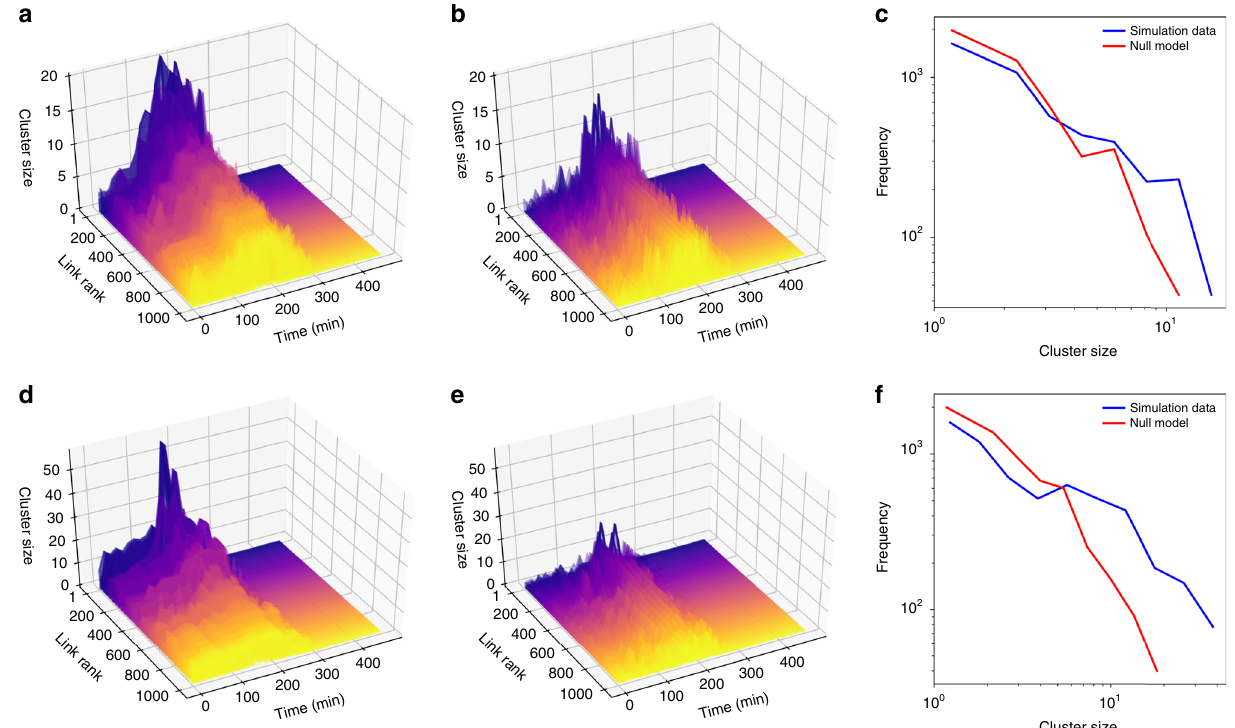
Fig. 6 Evolution of the congested upstream clusters associated with congested links. Here, a and d show the change over time in the size of the congested clusters associated with links in Melbourne ’ s traf fi c network, while b and e depict the same results for the null model generated independently for each time step by drawing random λ i ( t ) ’ s for each link i from the same distribution as in the simulated data; links are sorted according to the maximum size of their congested upstream cluster and the results only show the top 1000 links. The distribution of the size of the congested upstream clusters for the Melbourne traf fi c simulation model and its null model counterpart at t = 180 is compared for c ρ = 0.5 and f ρ = 0.7. Larger congested upstream clusters are observed more frequently in the Melbourne traf fi c network model compared to the null model generated with the same structure and the same distribution of the link relative